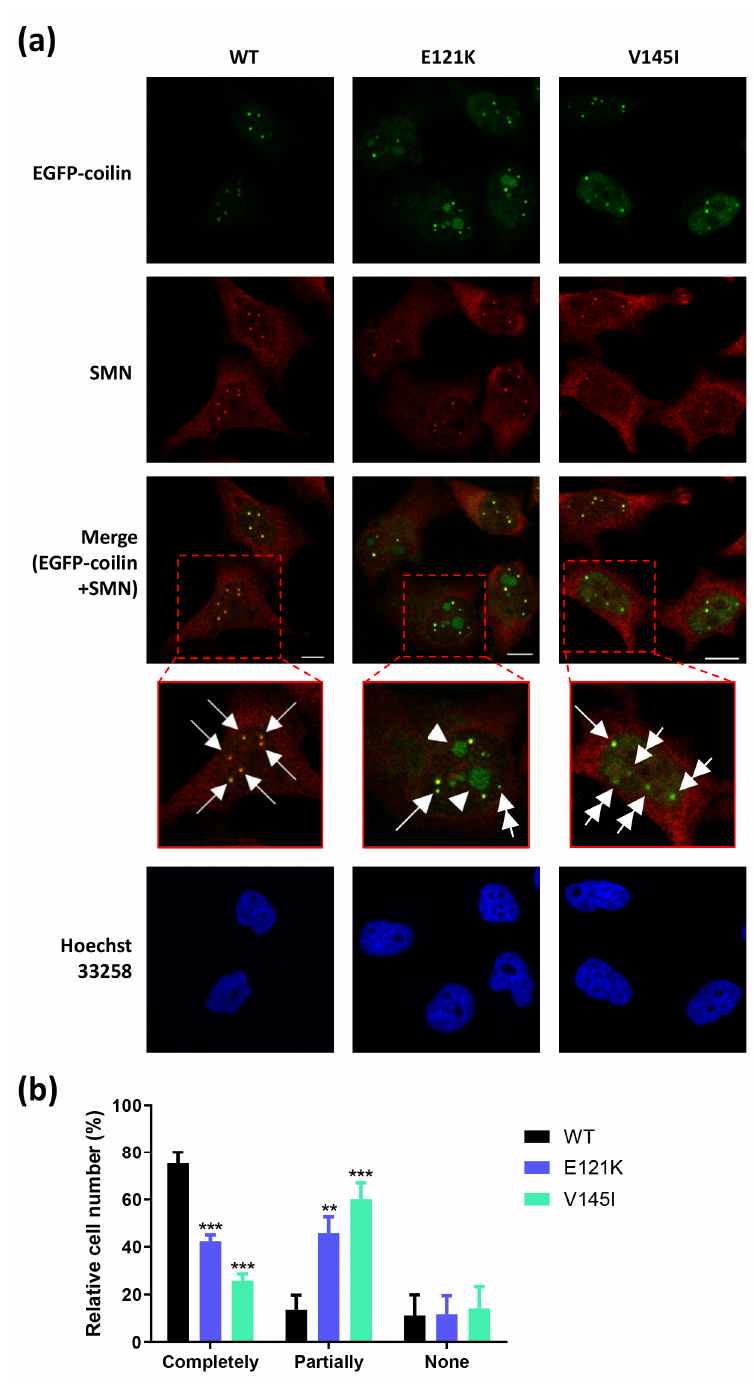
Figure 3. The effects of coilin WT and SNP variants on subcellular co-localization of coilin and SMN. ( a ) Immunofluorescence analysis of coilin and SMN co-localization status; single arrow indicates typical CB, which consists of the coilin and SMN protein; double arrow indicates residual CB, referring to the coilin lacking SMN protein; single arrowhead indicates coilin accumulation in the nucleolus; scale bar = 10 µm. ( b ) Co-localization status of coilin and SMN in WT ( n = 95–157), E121K ( n = 114–161), and V145I ( n = 127–166) cells were separated into three groupings: cells contained only the canonical CBs (completely), cells with mixed co-localization status (partially), and cells with no coilin and SMN co-localization (none); Student’s t -test was performed to determine significant differences between the means of SNP variant cells and control WT cells. ** p ≤ 0.01; *** p ≤ 0.001.